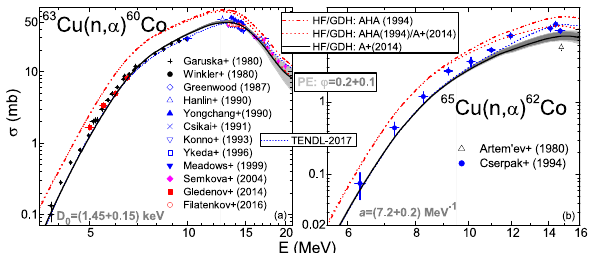
Comparison of measured [16] cross sections of 63 , 65 Cu( n ,α ) reactions with TENDL-2017 evaluation [14] (short- dotted) and PE + HF calculations using α -particle OMPs [5] (dash-dot-dotted), [3] (solid), and both (dotted), with uncertainty bands for NLD (light gray) and PE (gray) e ff ects on [3]